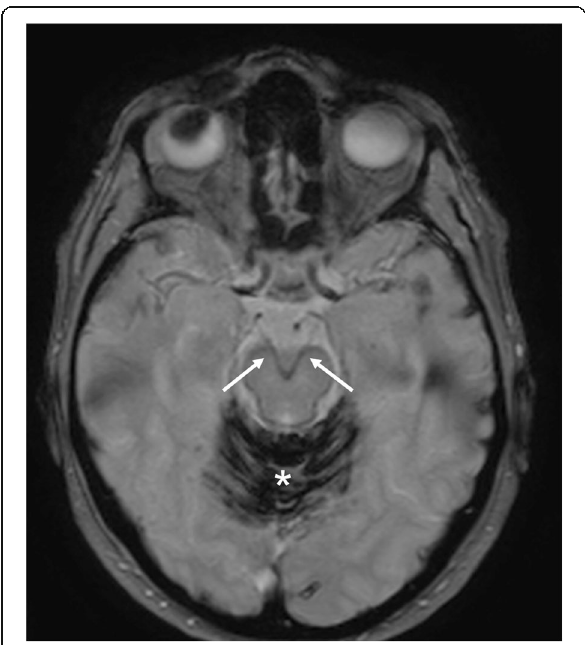
Fig. 33 Superficial siderosis. MRI T2*-weighted axial image demonstrates hemosiderin deposition along the course of oculomotor nerves (arrows). Massive hemosiderin deposition is also visible on the cerebellar folia (asterisk)